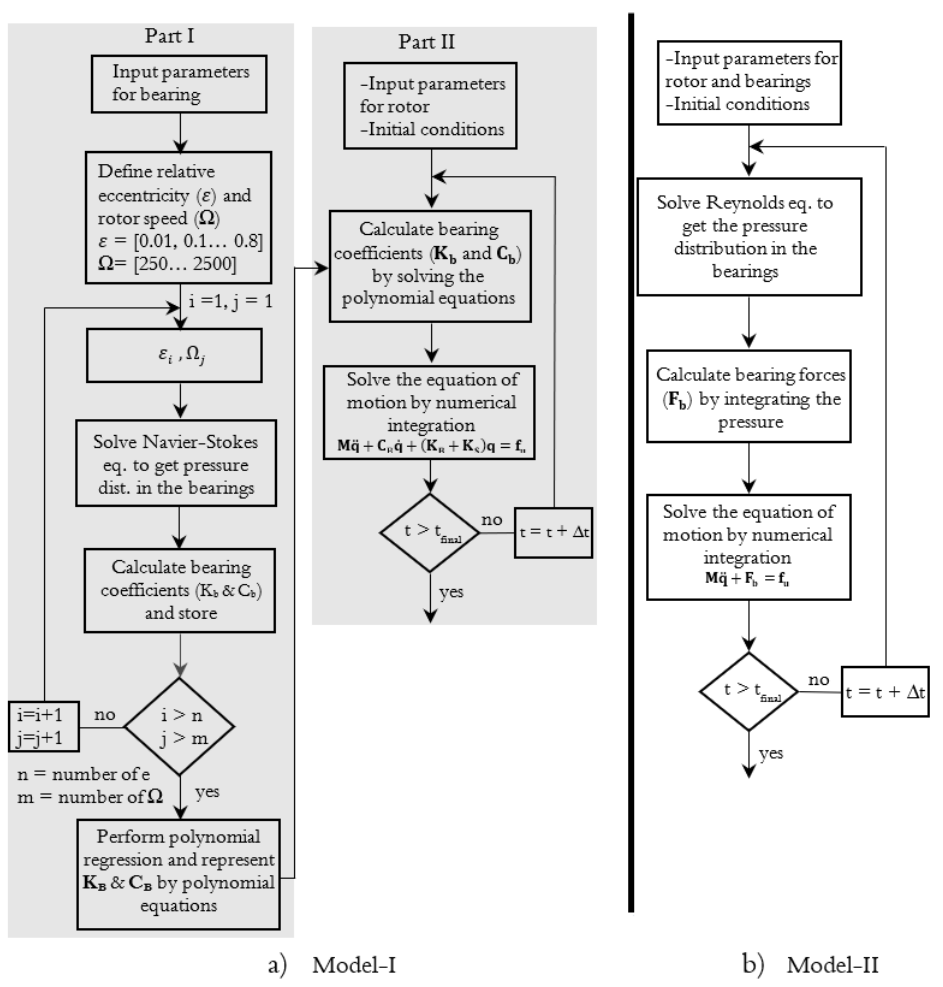
Figure 5. The flow chart of the ( a ) Model I: model described in this paper and ( b ) Model II: classical model.